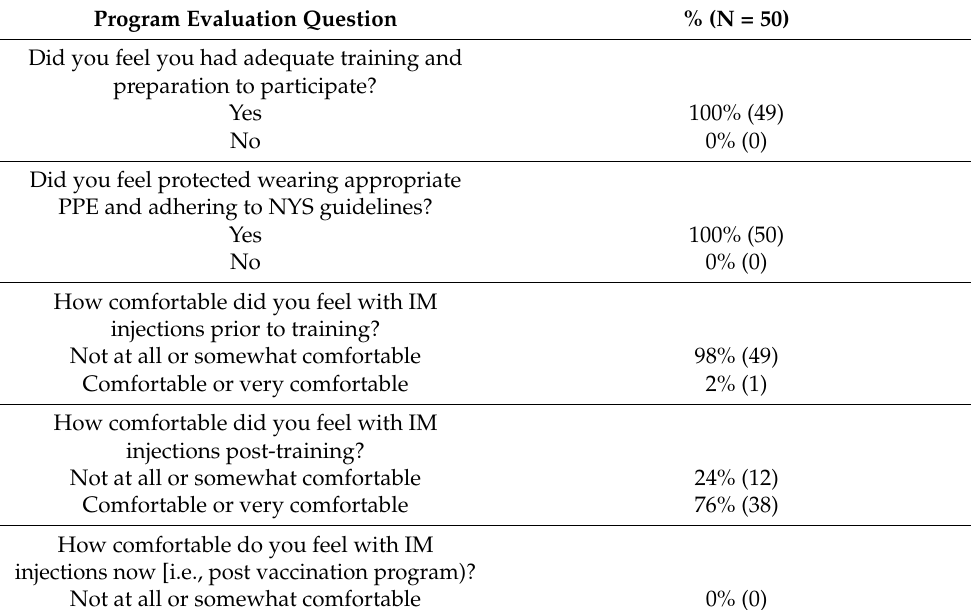
Table 3. Summary of student evaluations about vaccination